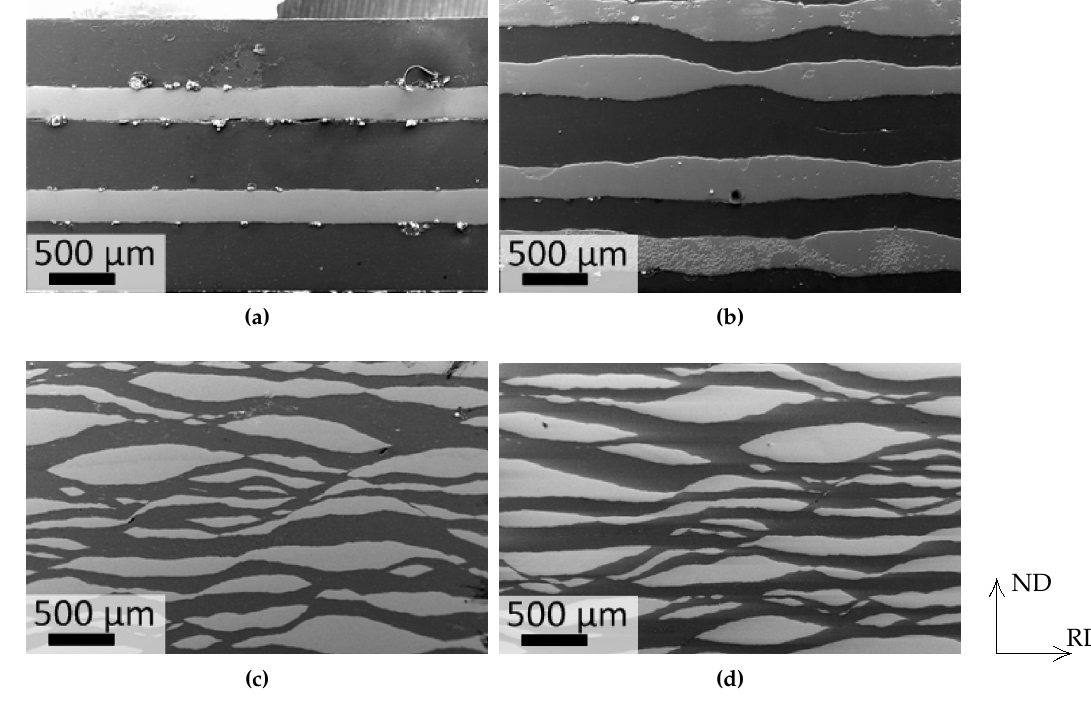
Figure 2. SEM micrographs showing the longitudinal cross-section of Ti/Al composite sheets after accumulatively roll bonding a five-layered composite, i.e. , after the first ( a ), second ( b ), fourth ( c ) and sixth ( d ) accumulative roll bonding (ARB) cycle (no intermediate heat treatment (IHT) was